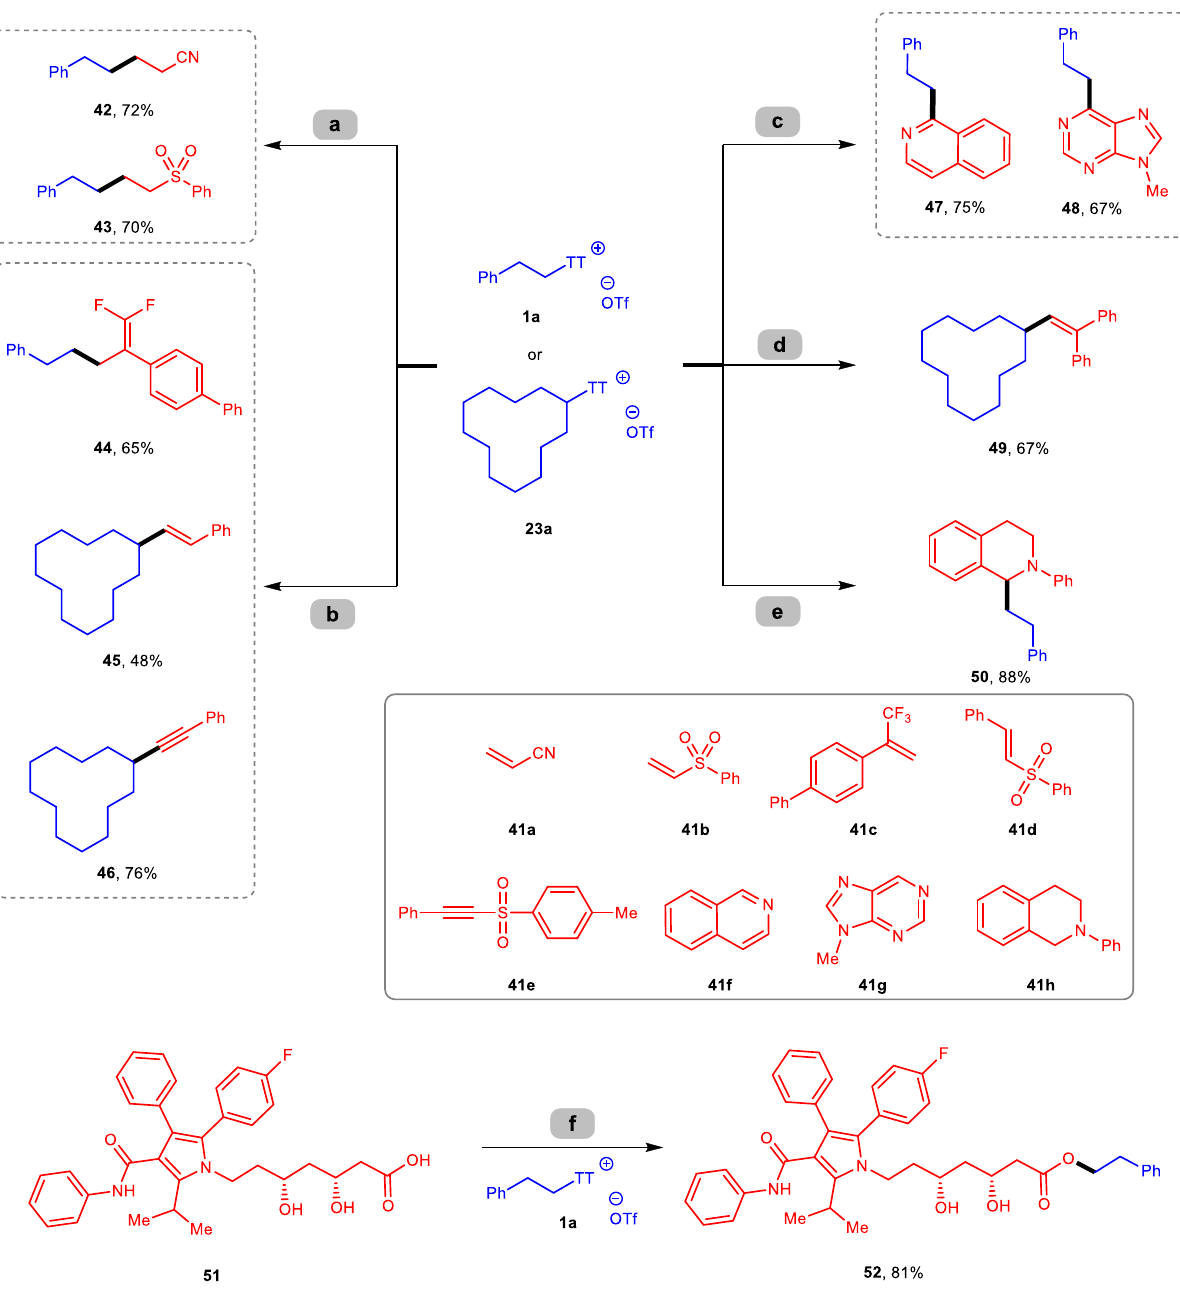
Fig. 8 Compatibility of thianthrenium salts in diverse transformations. a 1a (1.0 equiv), 41a-b (3.0 equiv), Ir[(ppy) 2 dtbpy]PF 6 (2 mol%), Hantzsch ester (2.0 equiv), DMA, rt, blue LED (440 nm); ( b ) 1a or 23a (1.0 equiv), 41c – e (1.5 equiv), Ir[(ppy) 2 dtbpy]PF 6 (2 mol%), DIPEA (3.0 equiv), CH 3 CN, rt, blue LED (440 nm); ( c ), for 46: 41f-g (1.0 equiv), 1a (1.5 – 2.0 equiv), Ir[(dFCF 3 ppy) 2 dtbpy]PF 6 (2 mol%), TfOH, DMA, rt, blue LED (440 nm); ( d ) 23a (1.0 equiv), 1,1-diphenylethylene (1.5 equiv), Ir[(ppy) 2 dtbpy]PF 6 (2 mol%), DABCO (1.0 equiv), CH 3 CN, rt, blue LED (440 nm); ( e ) 41 h (1.0 equiv), 1a (2.0 equiv), Ir[(ppy) 2 dtbpy]PF 6 (2 mol%), KHCO 3 (3.0 equiv), CH 3 CN, rt, blue LED (440 nm); ( f ) 51 (1.0 equiv), 1a (1.0 equiv), K 2 CO 3 (3.0 equiv), THF, ef fi cient and mild de fl uorinative alkylation of α -tri fl uoromethyl alkene 41c using thianthrenium salt 1a as a radical precursor could produce gem-di fl uoroalkene 44 in a 65% yield 75 . Under the same reaction conditions, we also developed alkyl radical ole fi nation ( 45 ) and alkynylation ( 46 ) reactions with secondary thianthrenium salt 23a with sulfone reagents 41d - e 76 . The photoredox Minisci-type functionalization of isoquinoline ( 41 f ) and 9-methyl-9 H -purine ( 41 g ) with 1a ef fi ciently led to alkylation products 47 – 48 with catalytic amounts of Ir[dF(CF 3 )ppy] 2 (dtbpy)PF 6 and tri fl ate acid in DMA under a blue LED 77,78 . Treatment of 1,1-diphenylethylene